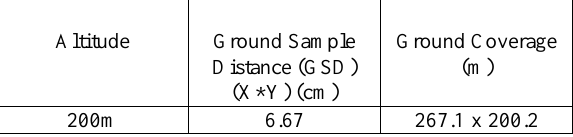
Table 2. Data description in Taean